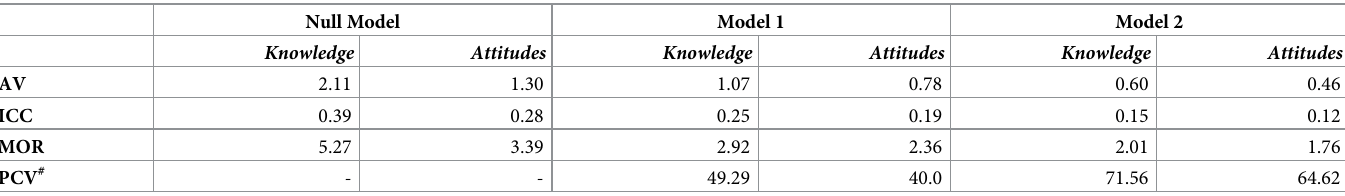
Table 4. Measures of variation in HIV knowledge and attitudes.